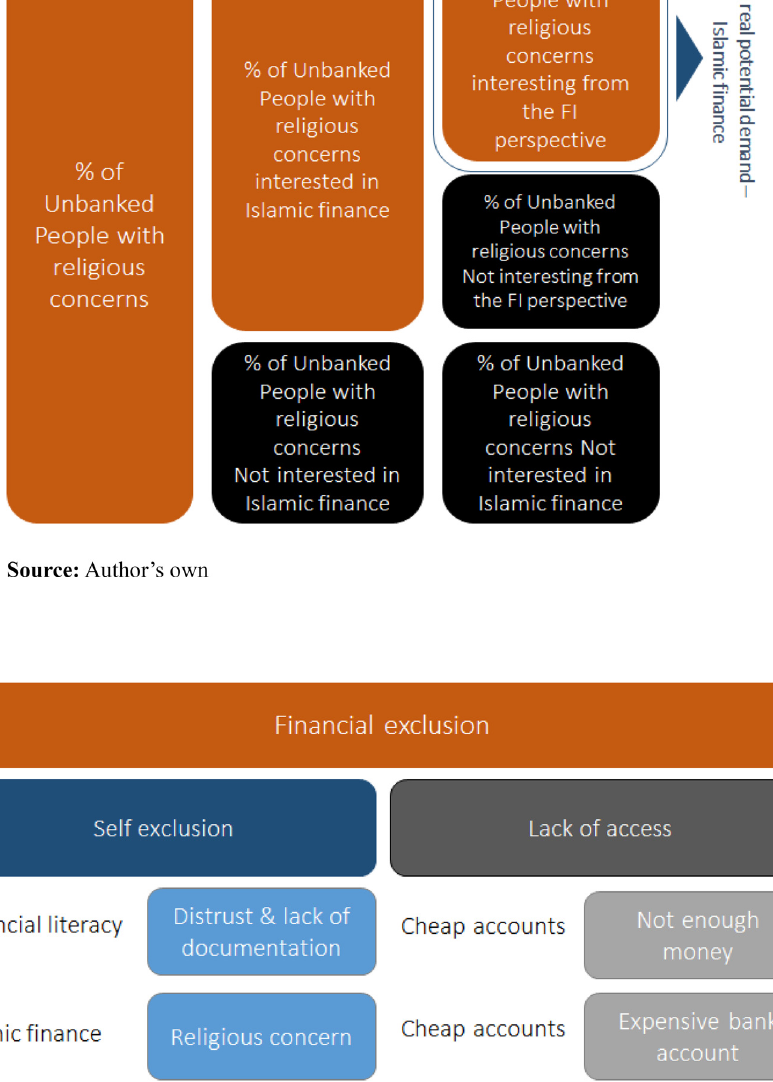
Figure 2. Mapping the unbanked people